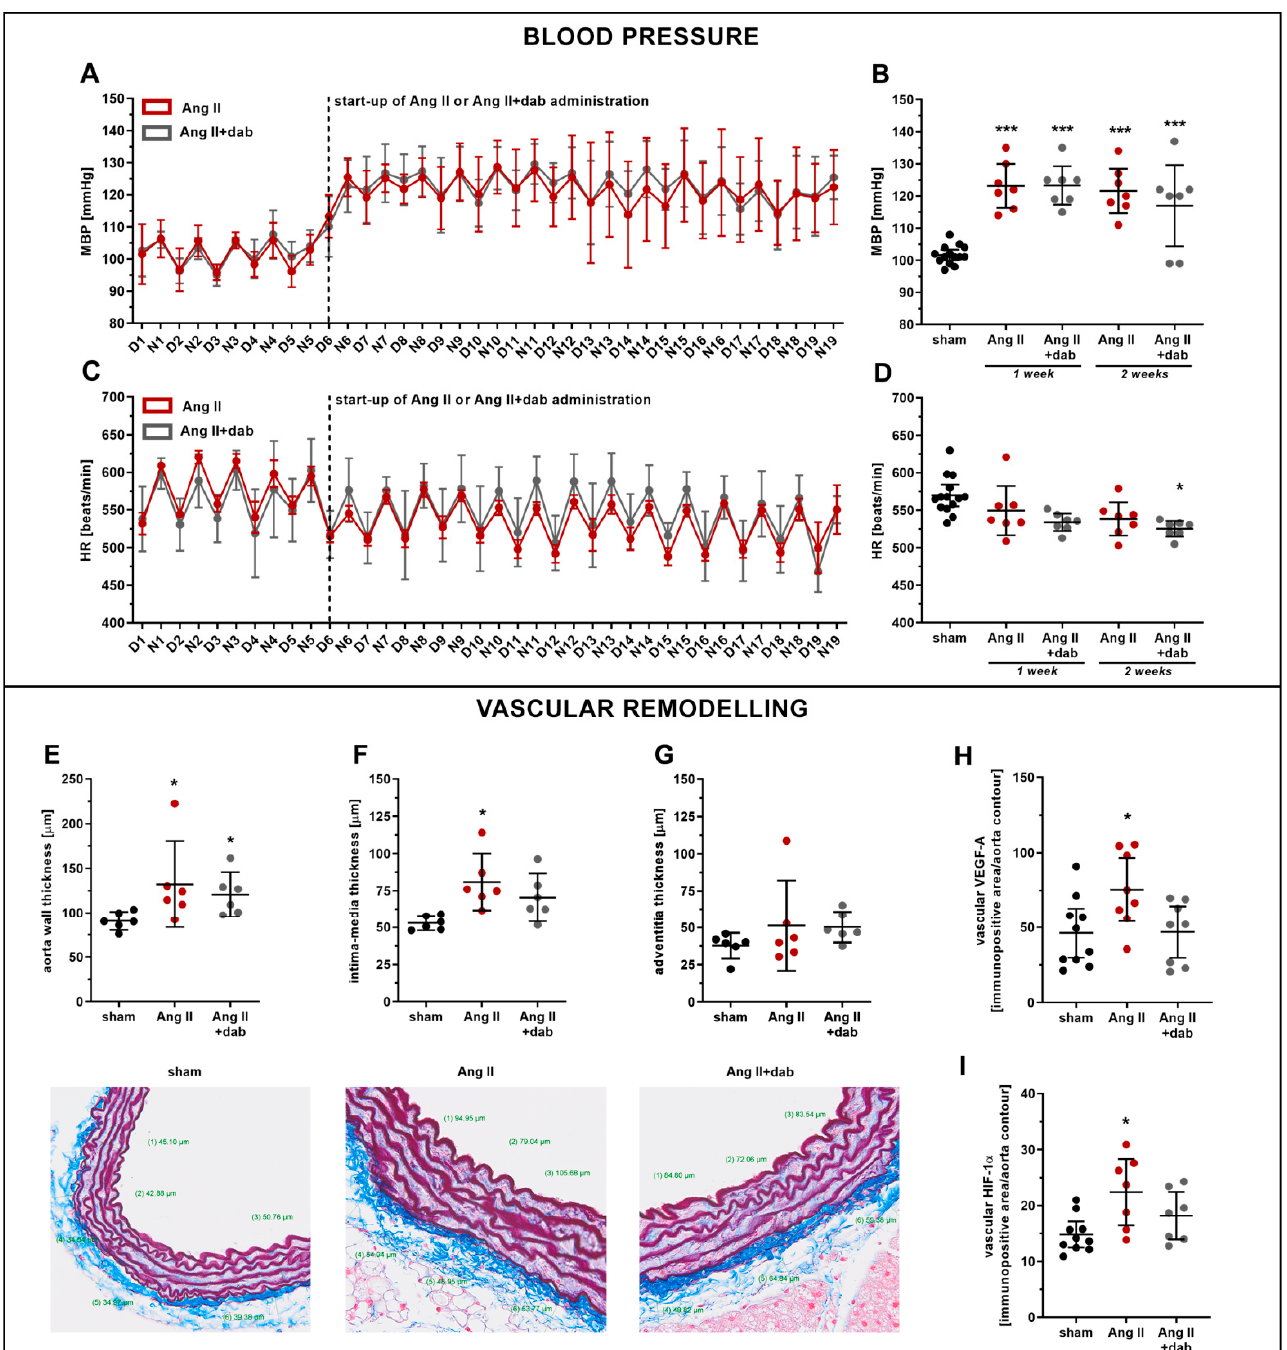
Figure 1. Effect of dabigatran on blood pressure, heart rate, and aortic remodelling in Ang II hypertensive mice. Mean blood pressure MAP ( A , B ; n = 7–14) and heart rate HR ( C , D ; n = 7–14) were continuously monitored by telemetry in mice subjected to i.v. continuous infusion of Ang II (144 µg/kg b.w per day; 2 weeks) via catheters. Quantitative analysis of aortic remodelling (OMSB staining) based on the thickness of the aorta wall ( E ; n = 6), intima-media ( F ; n = 6), and adventitia ( G ; n = 6) was performed in mice subjected to s.c administration of Ang II (1 mg/kg b.w per day; 1 week) via micro-osmotic pumps as well as vascular expression of VEGF-A ( H ; n = 8–10) and HIF-1 α ( I ; n = 8–10) (IHC analysis). Data are shown as means (–) ± 95% CI ( I ) and considered statistically significant at * p ≤ 0.05 and *** p ≤ 0.001 using Tukey’s post hoc ( B , D , F , H , I ) and Kruskal–Wallis ( E , G ) statistical tests. * indicates statistical difference between sham mice and Ang II- or Ang II+ dab-treated animals. D—measurements during the day; N—measurement during the